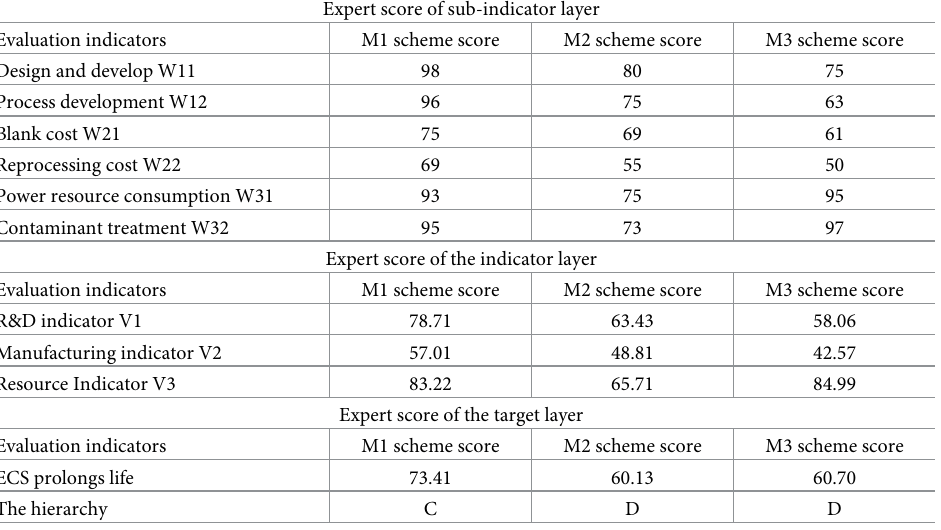
Table 9. Comprehensive evaluation